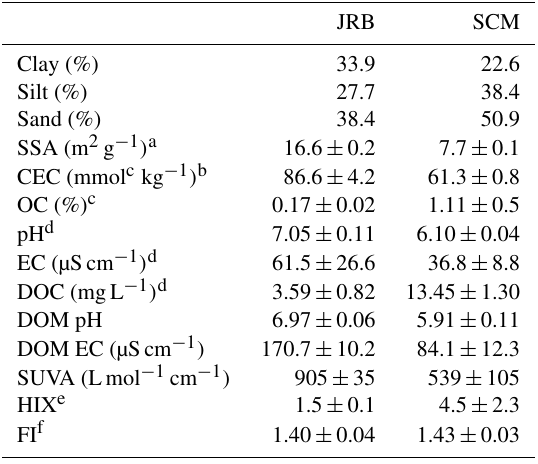
Table 1. Physicochemical characteristics of the study